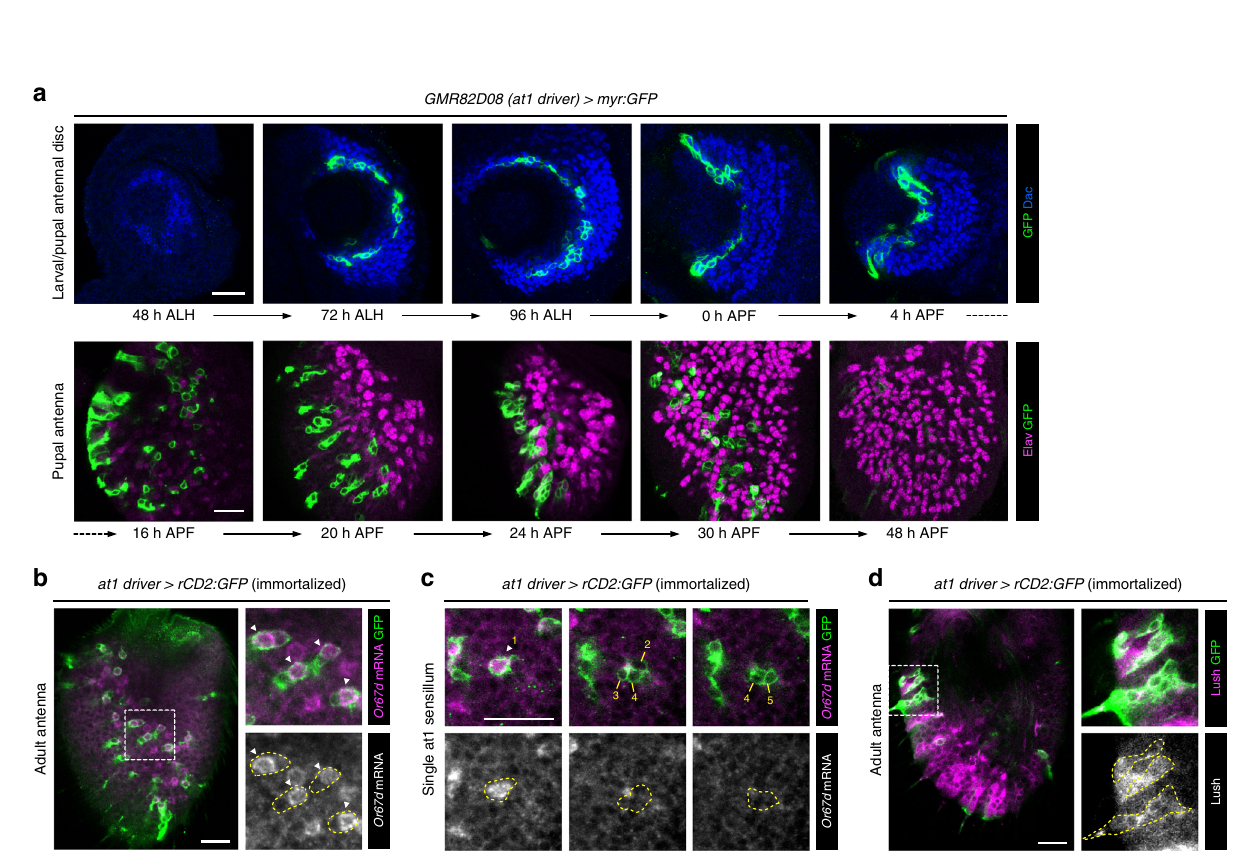
Fig. 3 Correlations between the olfactory fate map and circuit properties. a Distribution of different sensillar classes (from ref. 37 ), color-coded for their antennal disc arc of origin (one color may represent many different sensilla types that arise from the same arc). Sensilla originating from both Amos- positive arcs (red-yellow gradient) and Ato-positive arcs (blue-cyan gradient) are shown separately for clarity; both partially preserve their relative positions in the antenna: the internal arcs produce sensilla that have lateral (L) distributions while the peripheral arcs produce sensilla with more medial (M) distributions. b The relationship between Or/Ir protein phylogeny and the arc of origin of the corresponding SOPs (derived from the sensilla fate map in Fig. 2f). The Or phylogenetic tree is adapted from ref. 70 ; the Ir phylogenetic tree is adapted from ref. 14 . The arcs from which the OSNs originate are color-coded as in ( a ). Arc labels in black: high con fi dence OSN/sensillum mapping; arc labels in white: ambiguous OSN/sensillum mapping. c Different 3D surface views of the right antennal lobe (from ref. 16 ), in which glomeruli are colored according to the arc of origin of the SOPs from which the corresponding OSNs arise (as in ( a )). The split violin plots compare the pairwise distances between glomeruli 71 associated with a particular arc (denoted by black horizontal bars within the left, darker-colored kernel density estimation area), and the pairwise distances between each of the individual glomeruli associated with a particular arc and all other glomeruli not associated with the arc (gray bars within the right, paler-colored kernel density estimation area). Signi fi cant differences in distributions based upon one-sided Mann − Whitney U test are indicated: *** p < 0.0001. d Relationship between OSN birthplace and PN birth order. OSN classes (de fi ned by their glomerular innervation) are positioned on the vertical axis according to the arc of origin of the SOPs from which they arise, and ordered on the horizontal axis by the birth timing of their synaptic partners produced in the anterodorsal PN (adPN) neuroblast lineage (based on data from ref. 18 ). Black/white circles indicate OSNs mapped to mono-/polyglomerular PNs, respectively ( fi lled circles: OSNs from sensilla mapped with high certainty; un fi lled circles: OSNs from ambiguously mapped